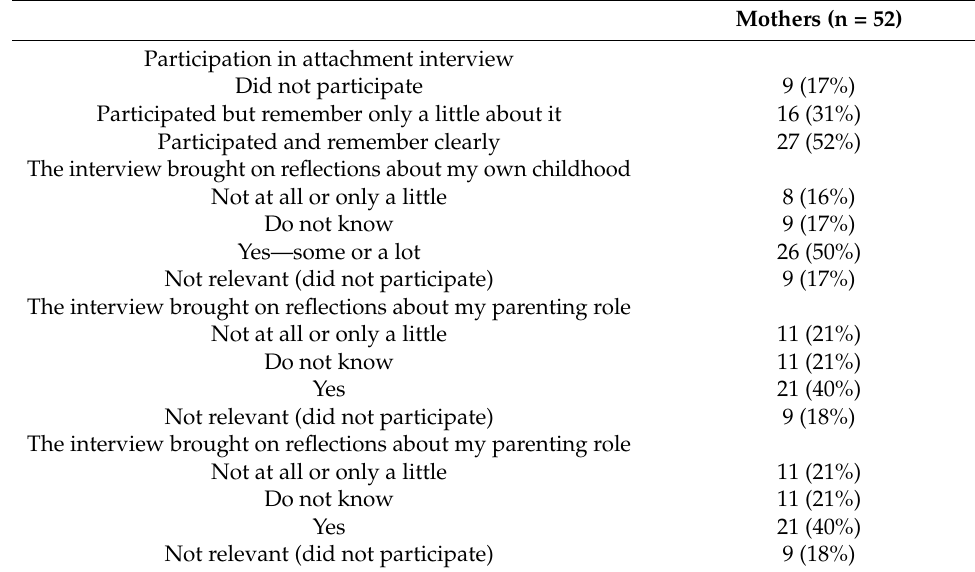
Table 4. Information on maternal participation in attachment interviews.